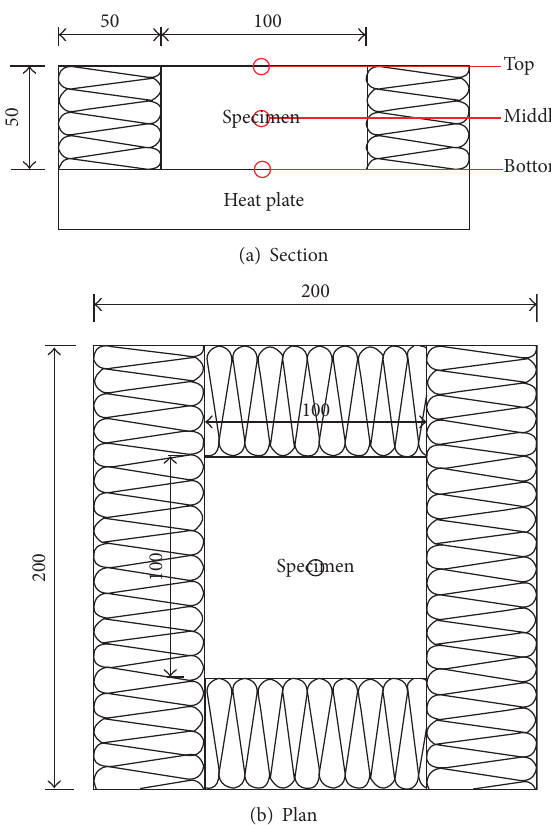
Figure 1: Specimen of the